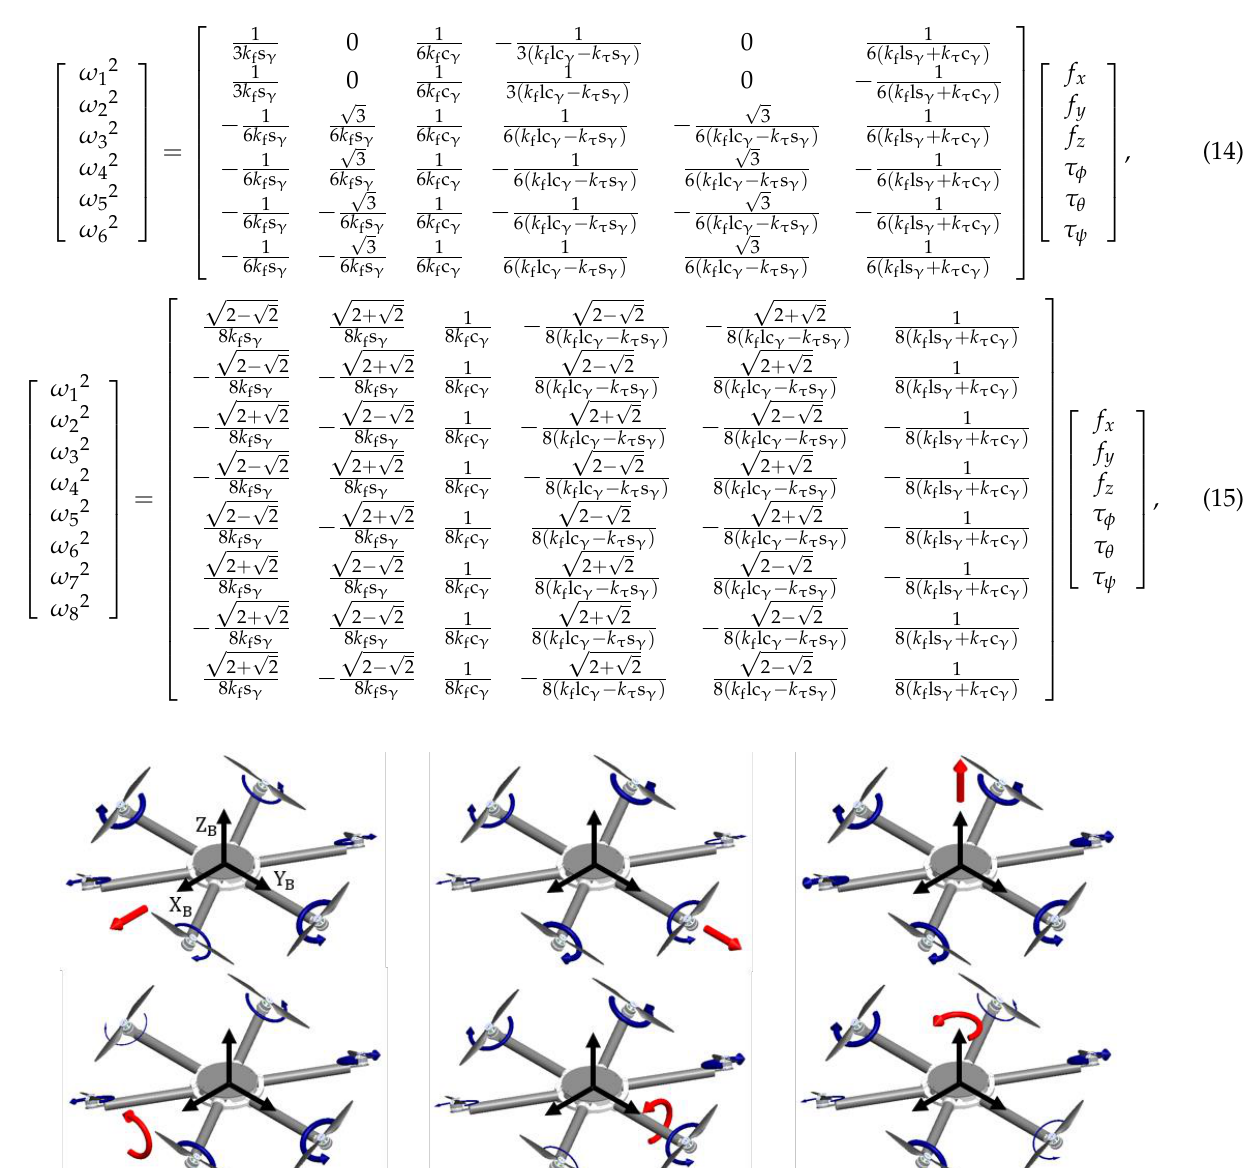
Figure 3. Schematic representation of PTX6 configuration maneuvering.